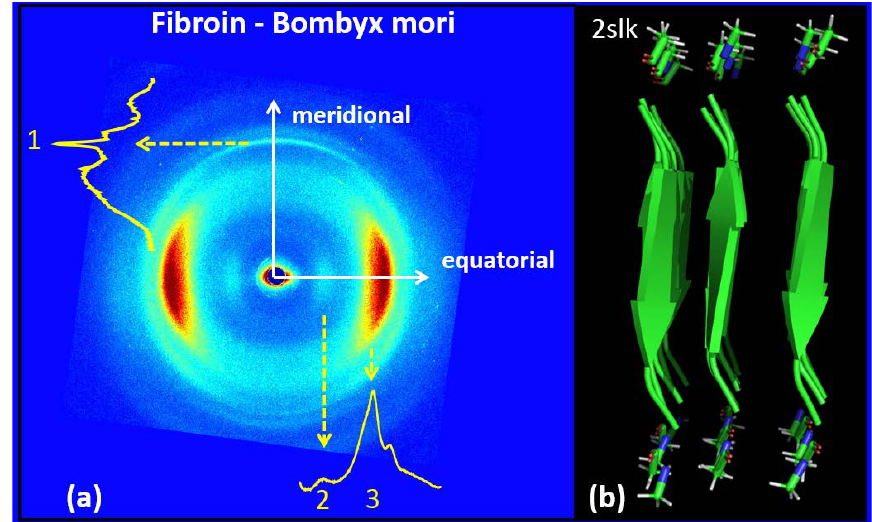
Figure 4. ( a ) Two-dimensional WAXS fiber diffraction pattern collected on fibroin- Bombyx mori with white arrows along the fiber axis (meridional) and that one perpendicular to it (equatorial). The corresponding 1D WAXS integrated profiles show the main peaks of the protein, the meridional peak (marked as 1) and the equatorial peaks (marked as 2 and 3), respectively; ( b ) 2slk molecular model of fibroin- Bombyx mori.